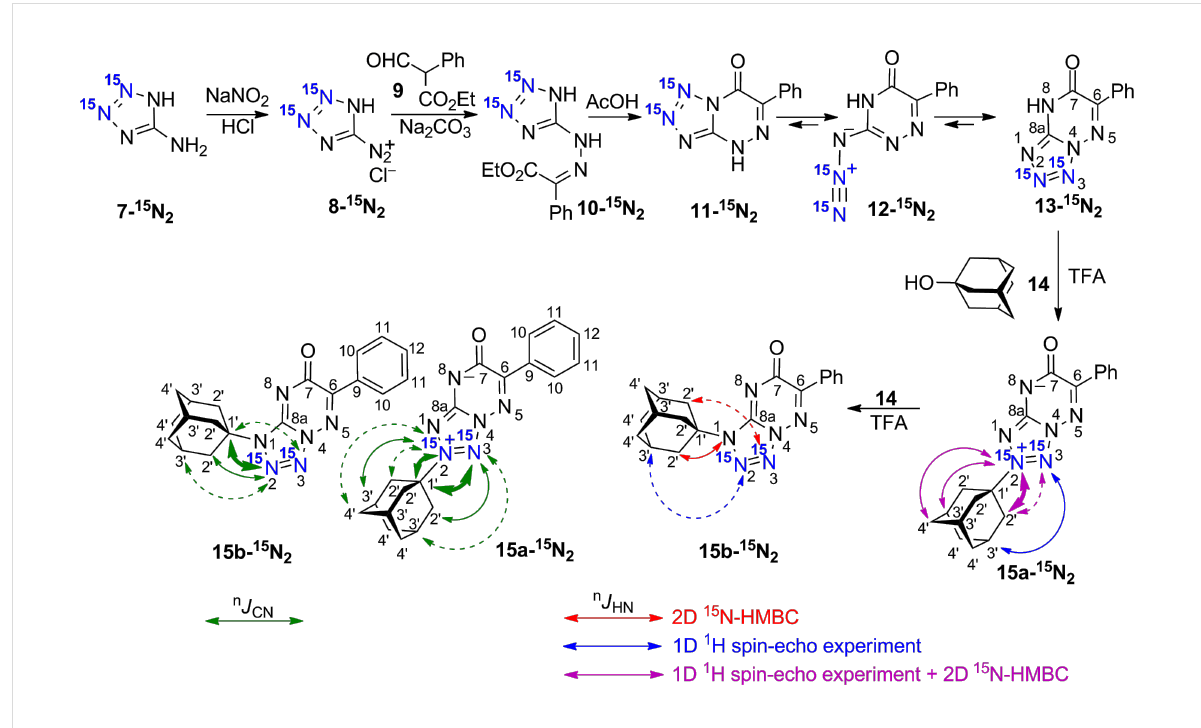
Scheme 1: Synthesis and adamantylation of 15 N-labelled 13- 15 N 2 and J HN and J CN data confirming the structures of adamantylated derivatives 15a,b- 15 N 2 . The J HN couplings measured by amplitude-modulated 1D 1 H spin-echo experiments and detected in the 2D 15 N-HMBC spectra are shown by blue, magenta, and red arrows (see the legend in the figure). The measured J HN values (blue and magenta) are classified into three cate- gories: J ≥ 0.8 Hz, 0.8 > J ≥ 0.1 Hz, and J < 0.1 Hz (bold solid, thin solid, and dashed arrows, respectively). The 1 H- 15 N cross-peaks observed in the 2D HMBC spectrum for the unlabelled and labelled nitrogen atoms are classified into three categories: strong, medium and weak (bold solid, thin solid, and dashed red arrows, respectively). The J CN couplings with adamantane carbons measured in the 1D 13 С spectra are classified into three categories: J ≥ 2 Hz, 2 > J ≥ 1 Hz, and J < 1 Hz (bold solid, thin solid, and dashed green arrows, respectively). The 1 J NN couplings observed in the 1D 15 N NMR spectra of 13- 15 N 2 (16.4 Hz), 15a- 15 N 2 (14.7 Hz) and 15b- 15 N 2 (15.3 Hz) are not